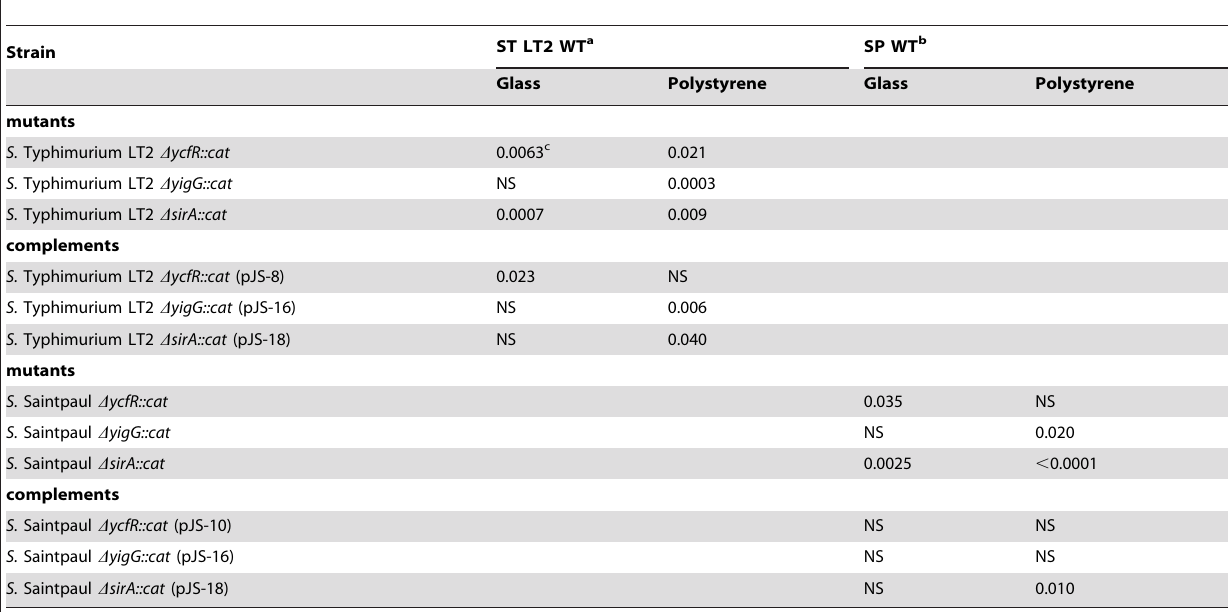
Table 2. Statistical analysis of S. enterica crystal violet attachment assays on glass and polystyrene surfaces.